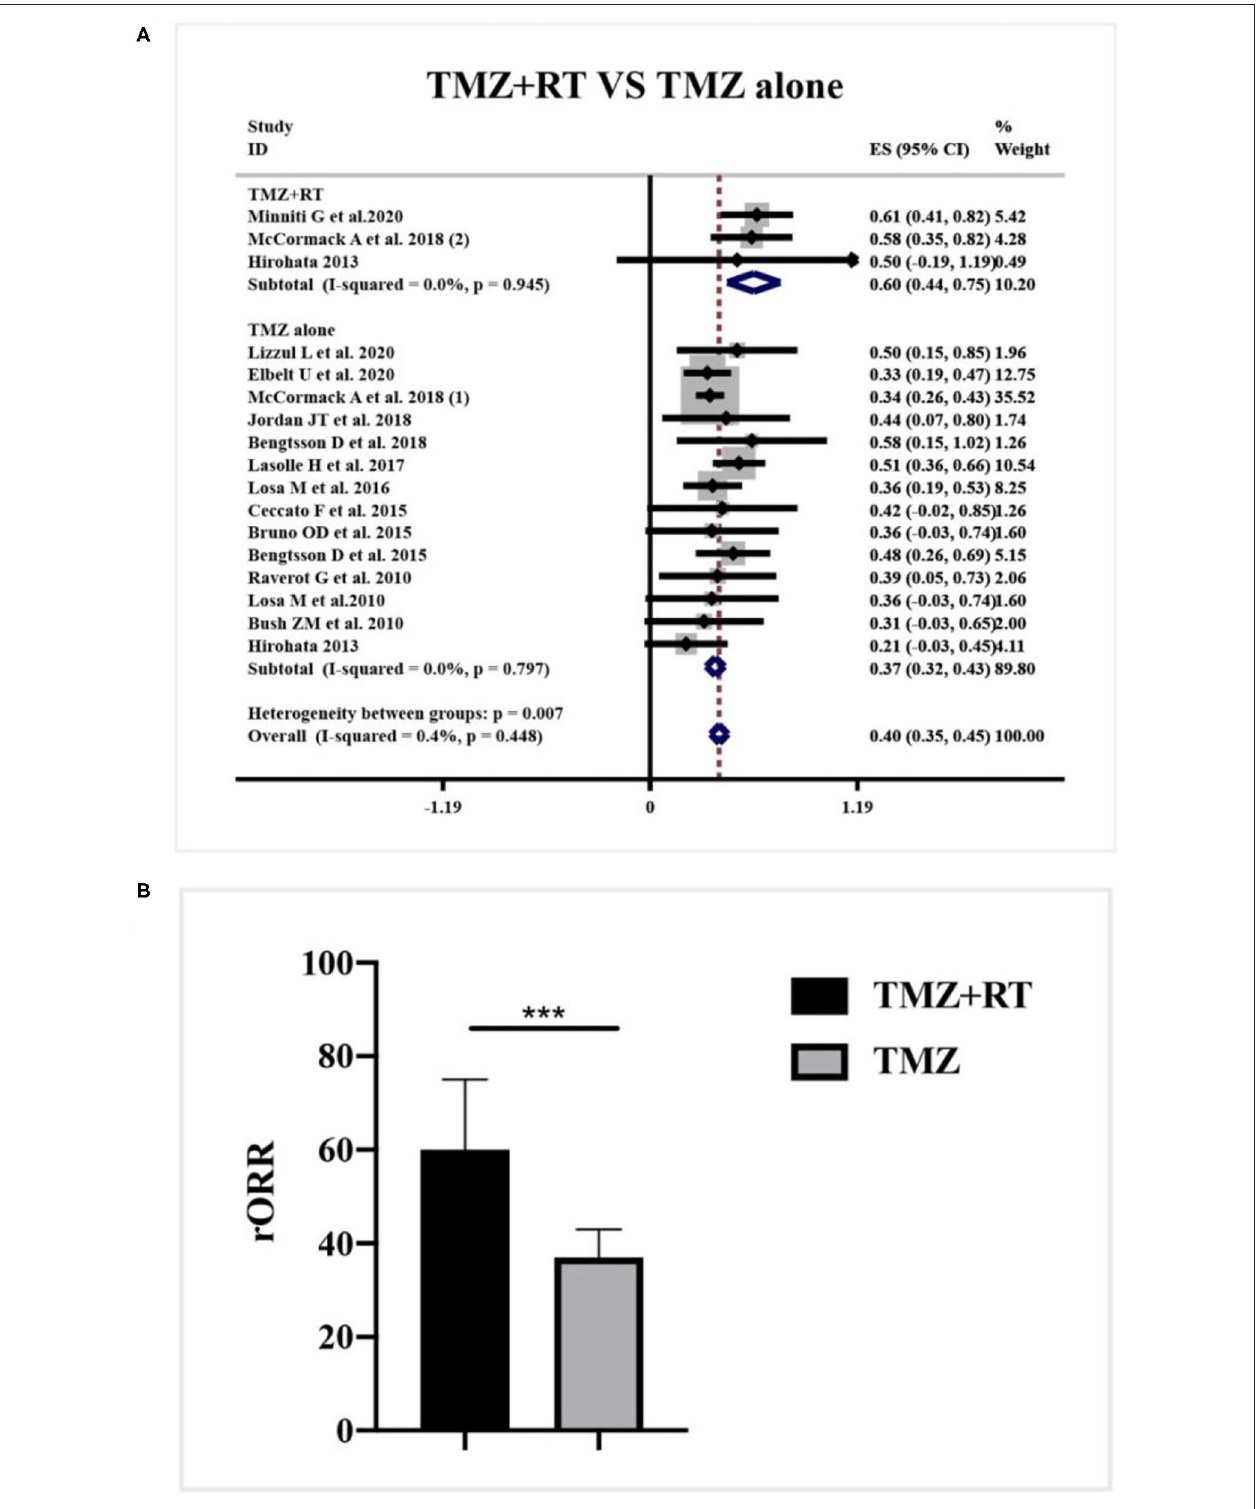
FIGURE 7 | Radiological response after concomitant application of radiotherapy and TMZ for patients with APT and PC. (A) Concomitant application of radiotherapy and TMZ generated 60% radiological response, and TMZ monotherapy elicited a 37% radiological response. (B) Quantitative histogram showed the combined therapy significantly increased the radiological response than TMZ monotherapy. *** P < 0.001.